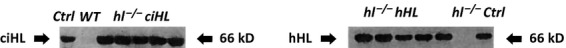
Western blot analysis for human HL immunoreactivity. Expression of human HL in postheparin plasma from hl−/−
ciHL (Left panel) and hl−/−
hHL mice (Right panel) were assayed by Western blot using a monospecific antihuman HL polyclonal antibody (12). As expected immunoreactivity was present in plasma from ciHL- and hHL- expressing mice and absent in negative control WT (with murine HL) and hl−/− mice. Positive controls were plasma from hl−/−
ciHL mice (Left panel) and hl−/−
hHL (Right panel).